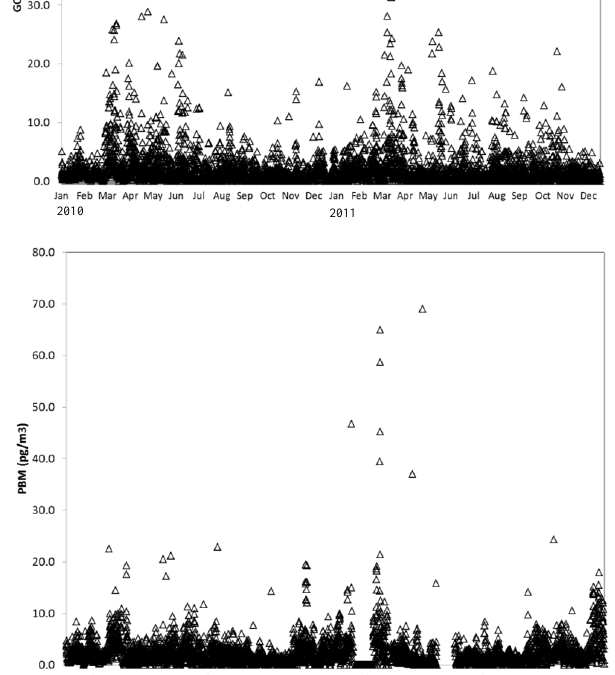
Fig. 2. Time series concentrations of GEM, GOM, and PBM be- tween January 2010 and December 2011.